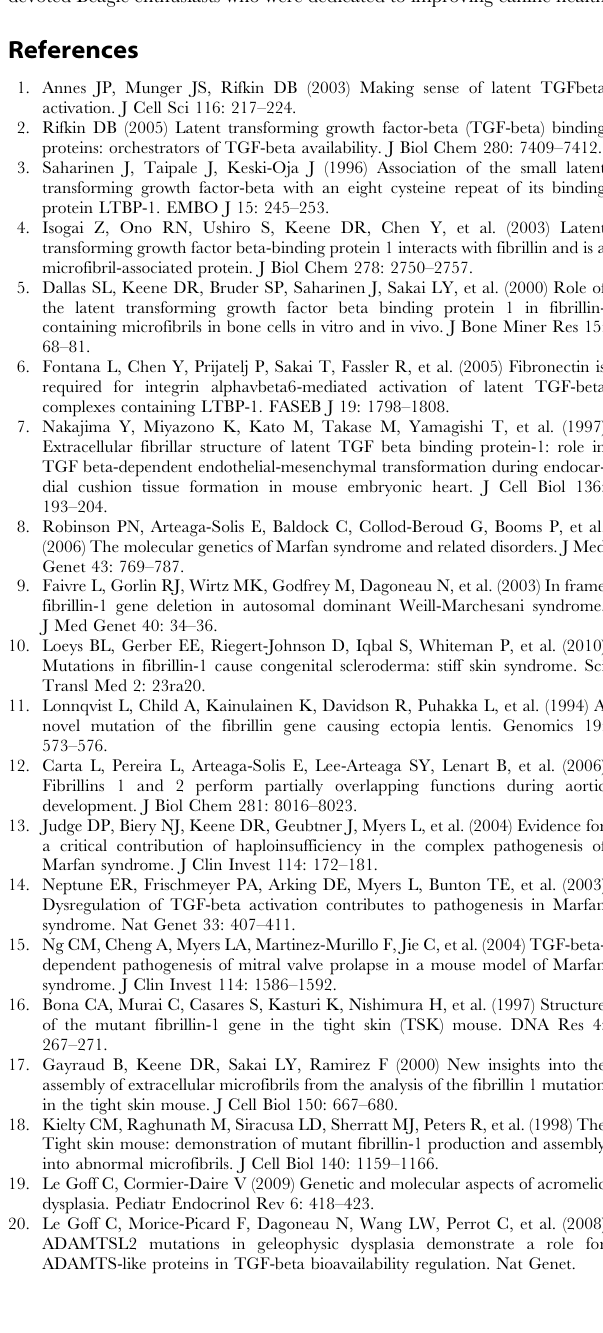
Table S5 Primer sequences for RT-PCR and sequence analysis of the ADAMTSL2 transcript.